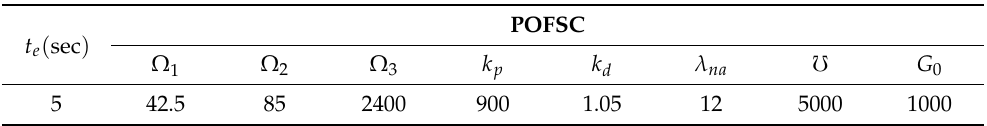
Table 5. Parameters of the proposed POFSC in fifth-order path-tracking positioning control for the elbow joint.